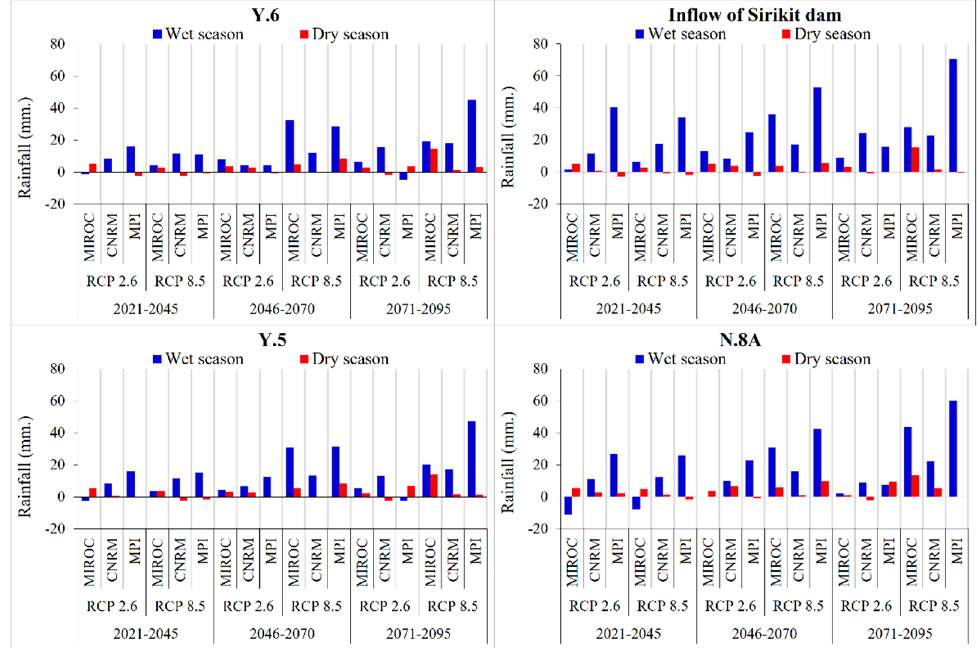
Figure 7. Changes in average annual rainfall and runoff in the reference period (1981–2005) with the near future, intermediate future, and far future under scenarios RCP 2.6 and RCP 8.5.